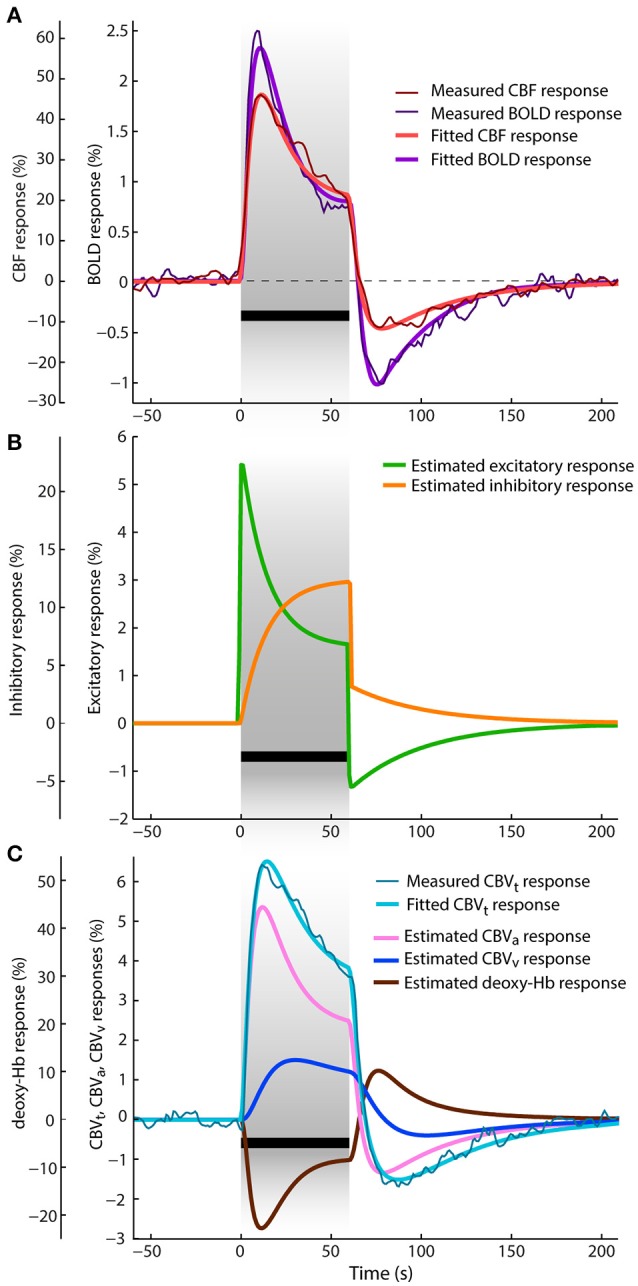
Data and results depiction of experiment II. This figure and its sections follow the same plotting format as Figure 2. The average CBF, BOLD and total CBV responses are replotted versions of the data reported in Figure 1 of Jin and Kim (2008). (A) The fitted and average measured CBF and BOLD responses. (B) The estimated excitatory and inhibitory responses. (C) The average measured and fitted total CBV responses are displayed with dark thin and light think cyan lines, respectively. Next, to the estimated venous CBV response and deoxyhemoglobin content responses, also the arterial CBV response is depicted (pink line).